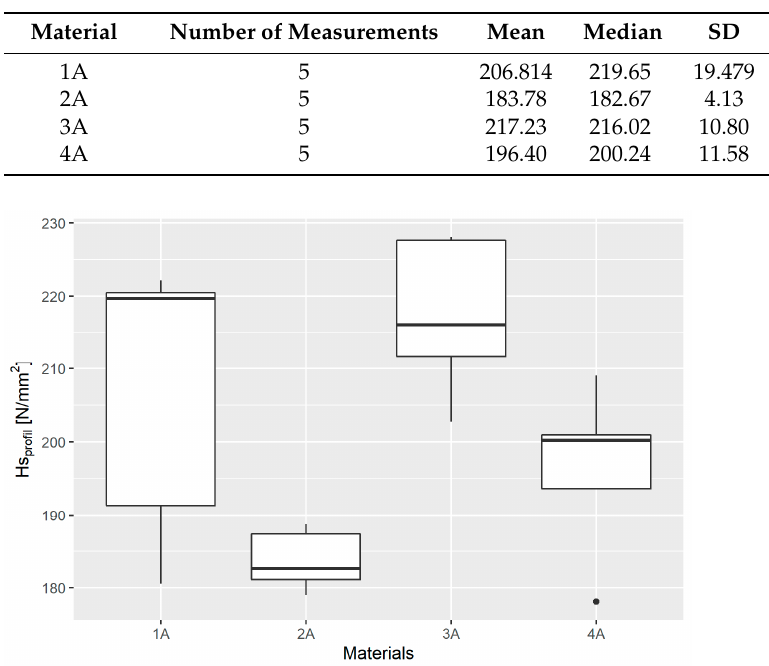
Table 6. Basic descriptive statistics of the scratch hardness results based on the measurements made using the optical profilometer ( Hs profil ) in individual material groups.